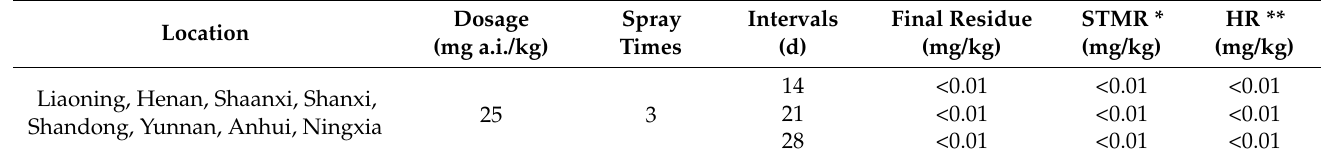
Table 2. Final residues of benziothiazolinone in apple samples.